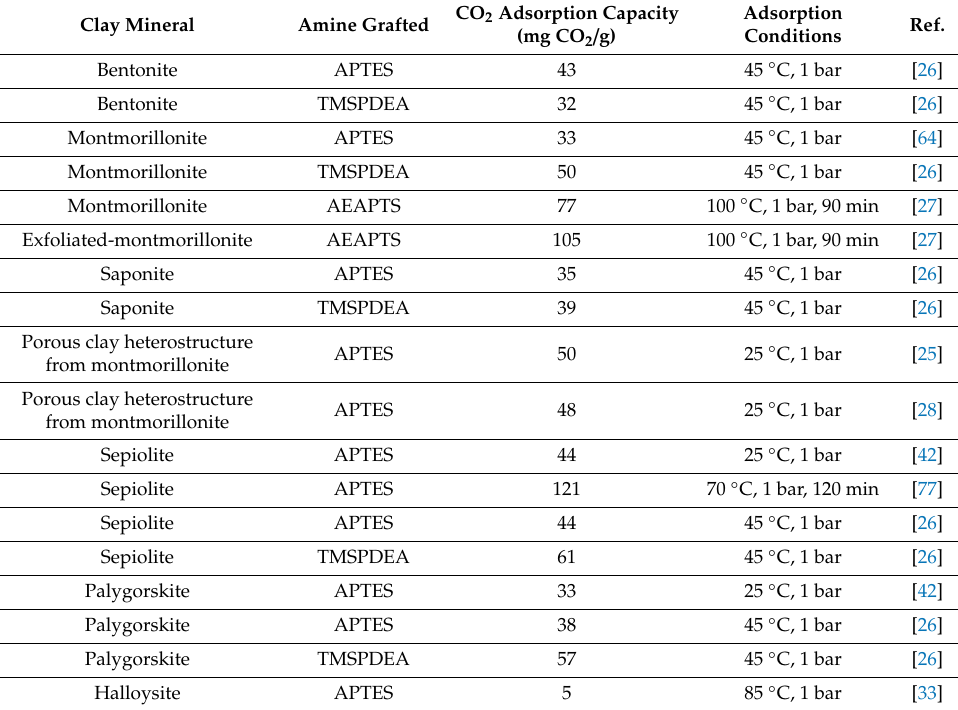
Table 5. CO 2 adsorption capacity of clay minerals functionalized with amine groups by grafting.